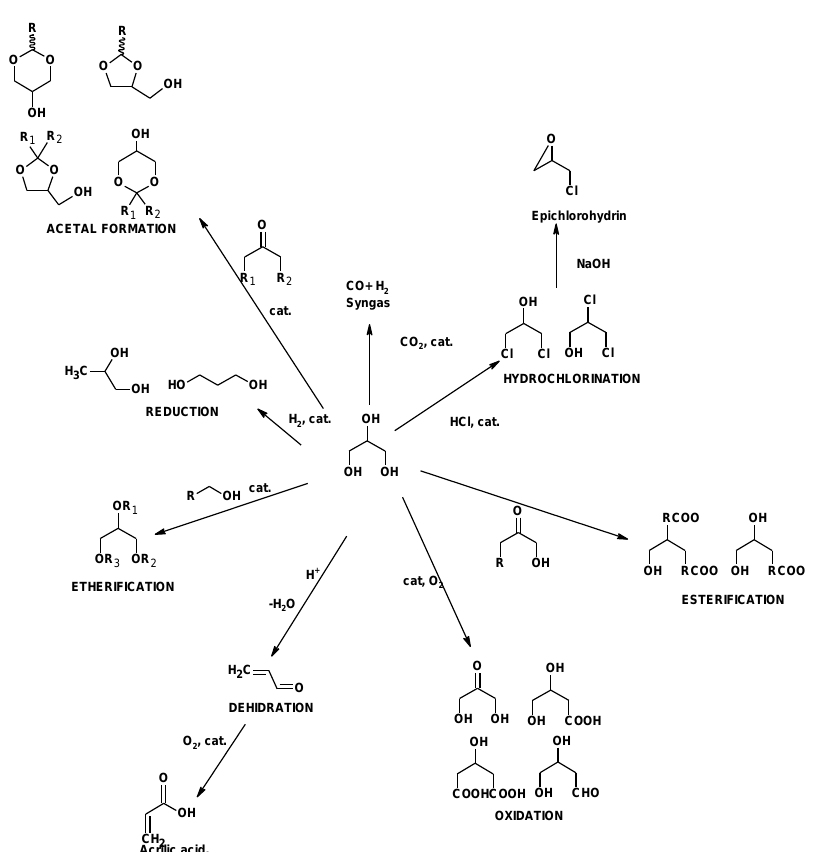
Figure 1. Reactions in which glycerol is used as a building block to make more-complex molecules [51]. Glycerol is also involved in biological transformations. Crude glycerol is a suitable feedstock in microbial fermentation. It has been used for the production of succinic acid, using the bacterium Anaerobiospirillum succiniciproducens [52] and citric acid, using the yeast Yarrowia lipolytica. The e ffi